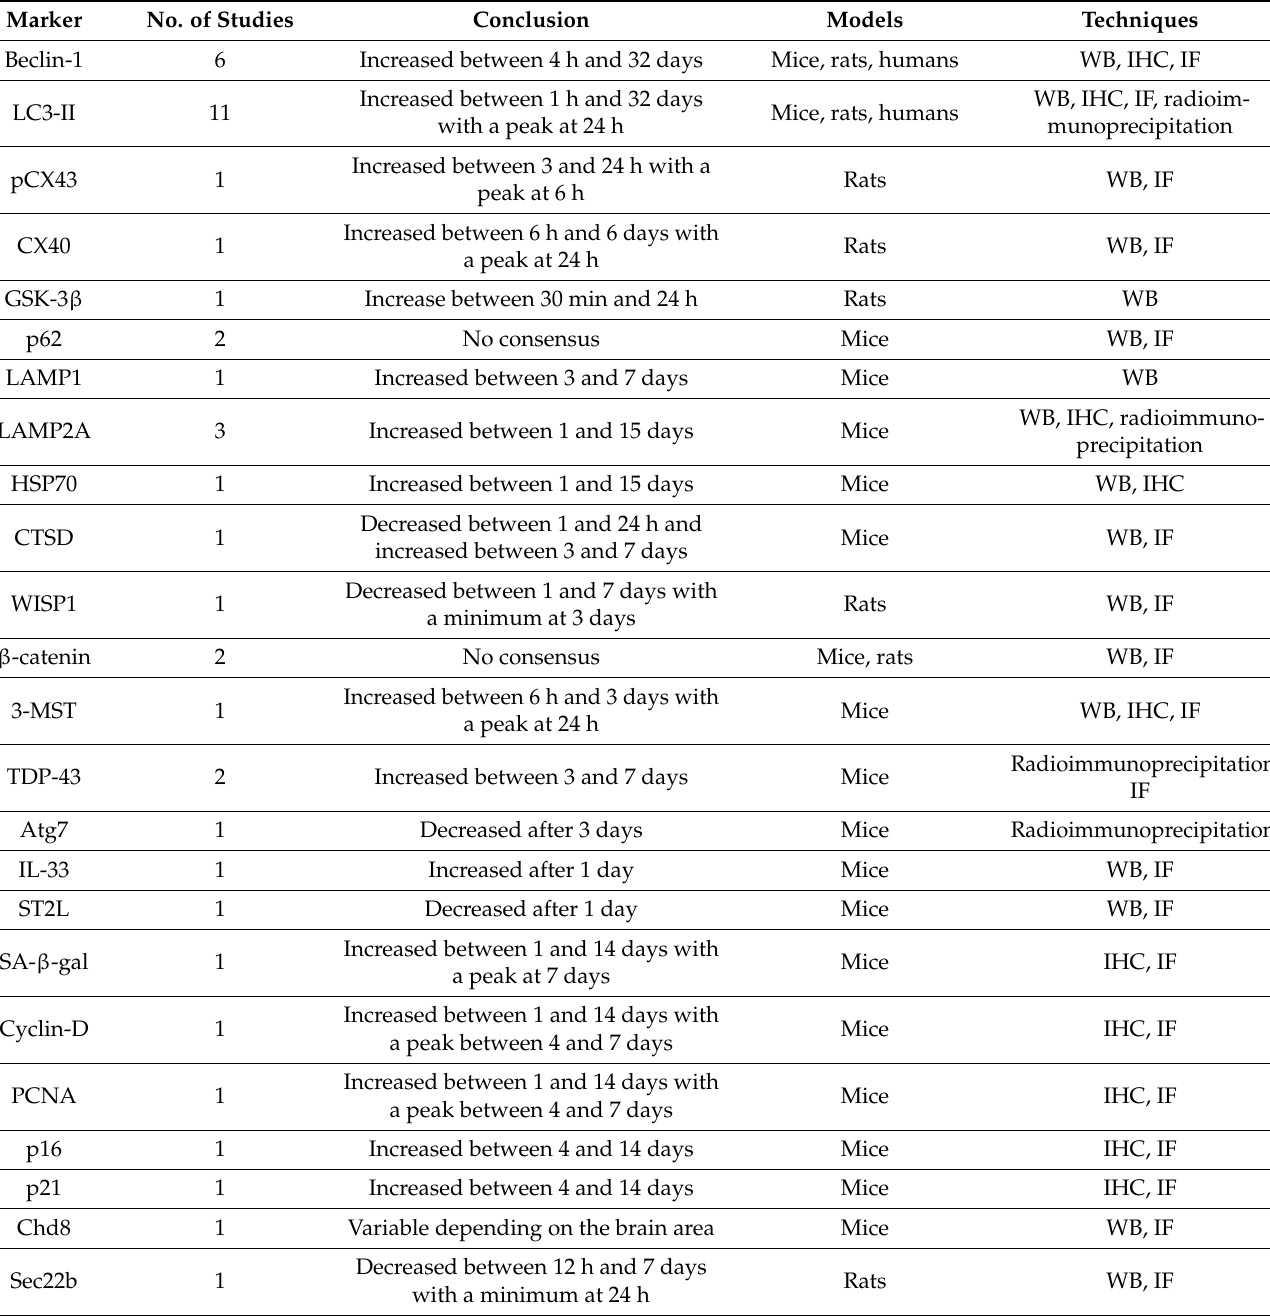
Table 2. Summary of markers and major findings for each one of